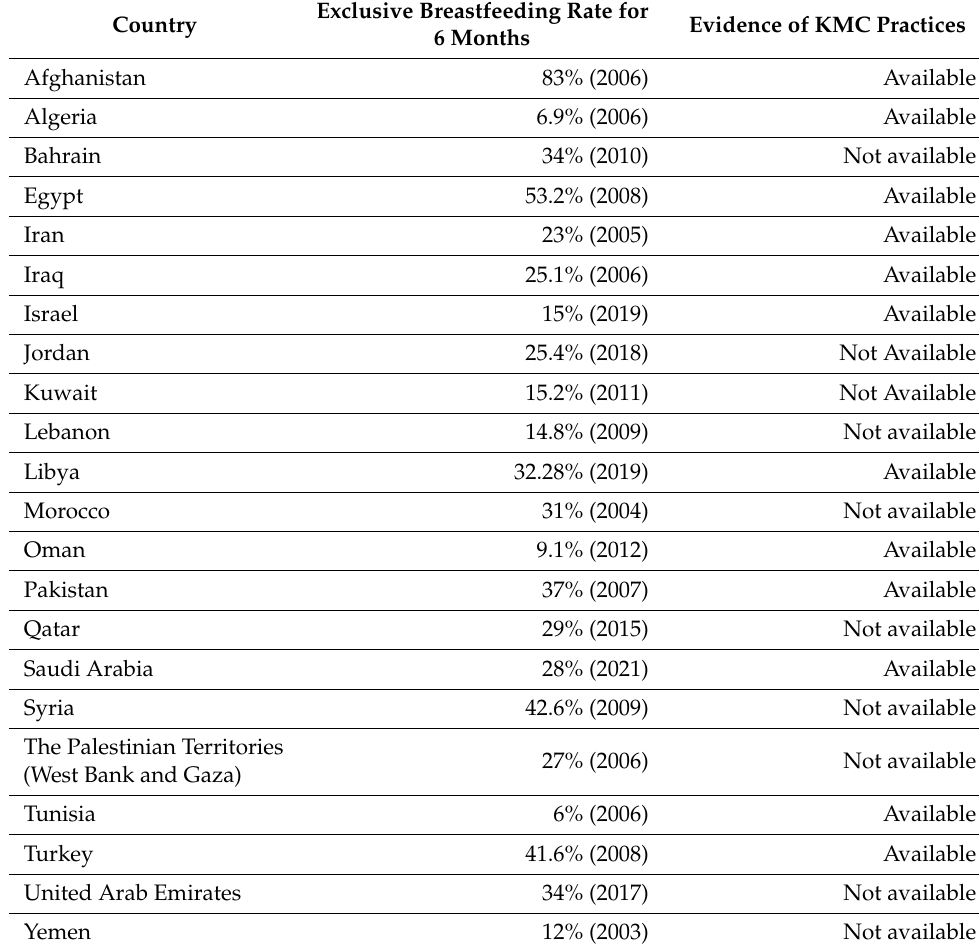
Table 1. Middle Eastern countries and rate of exclusive